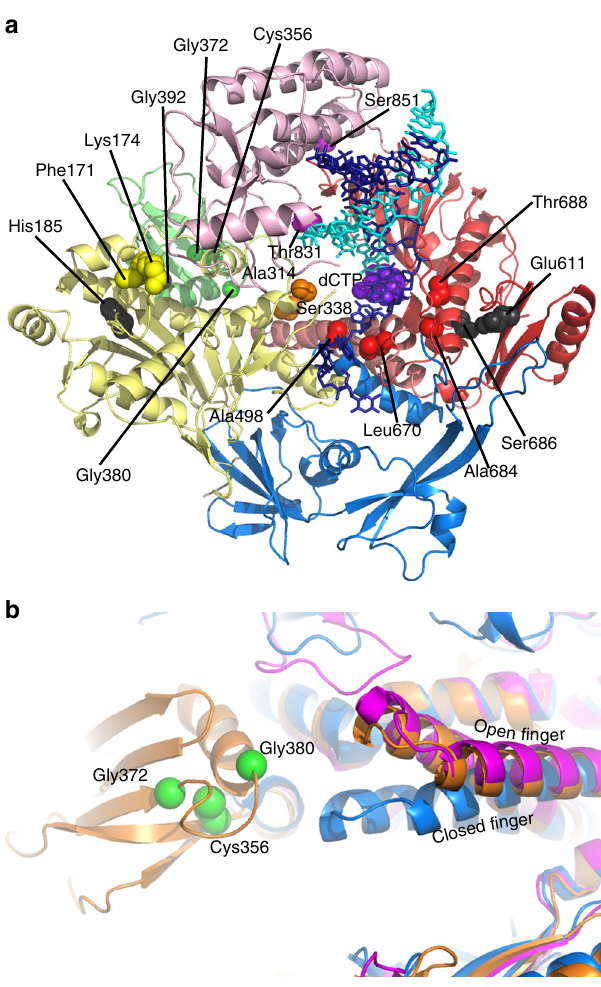
Fig. 6 Analysis of drug-resistance mutations on E9. a Locations of different mutants listed in Table 2 on the model of E9 in complex with DNA in elongation mode. Domains of the polymerase are color coded as in Fig. 1a. b Analysis of the fi nger domain movements: in magenta, the DNA-bound structure of human pol α (PDB 5iud), in orange E9 after superposition of the palm and exonuclease domains onto the binary complex of human pol α , in blue the ternary complex of yeast pol δ with DNA and an incoming nucleotide (PDB 3iay). Upon nucleotide binding, the tip of the fi nger of E9 may move close to the insert 2 domain allowing a potential contact, which would occur in vicinity of the PAA resistance mutations depicted as